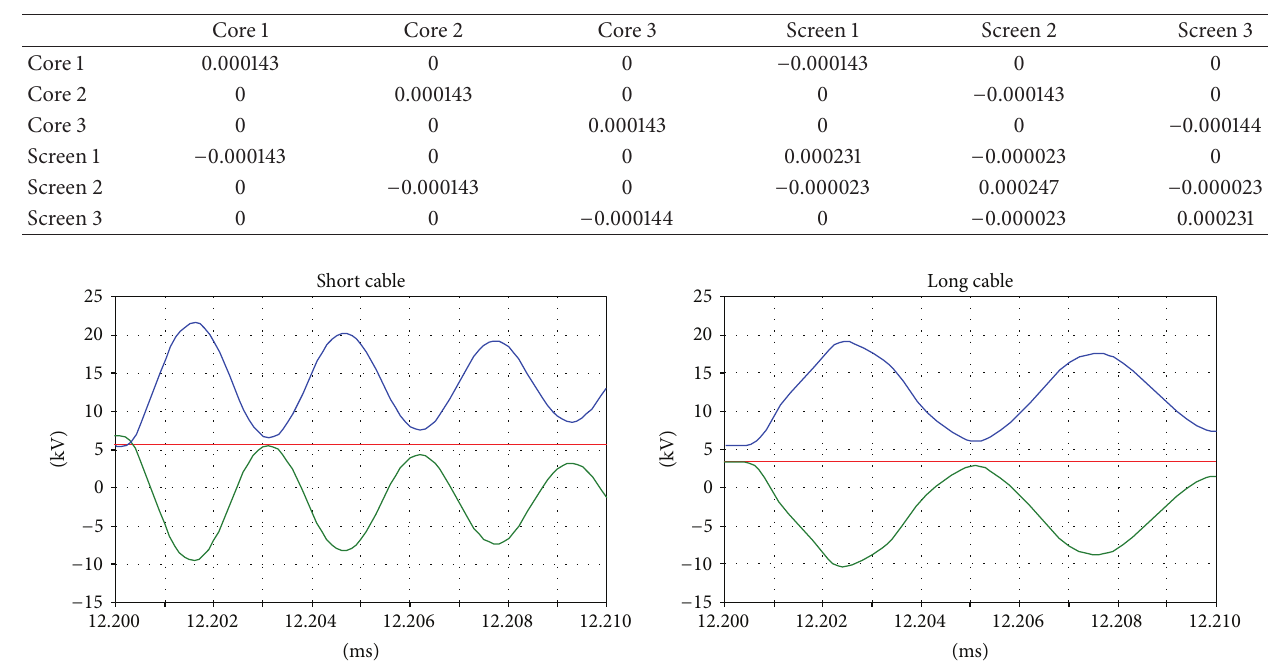
Table 2: The self and mutual capacitance matrix of the MV cable line.